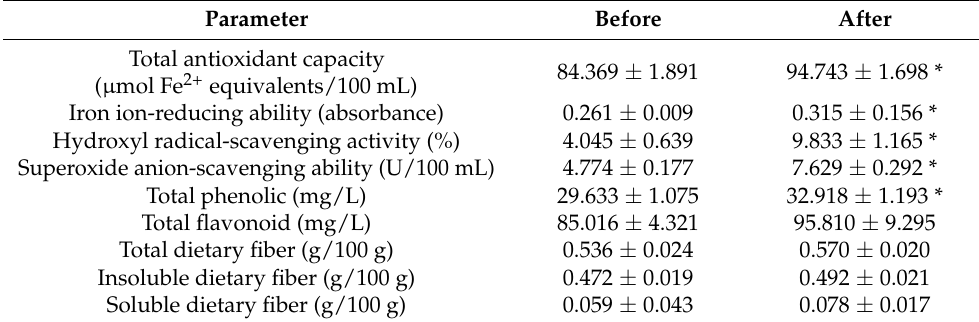
Table 3. Changes in antioxidant activity and the contents of total phenolic, total flavonoid, and dietary fibers in the R–B mixed juice before and after fermentation with L. plantarum TUST-232. Parameter Before